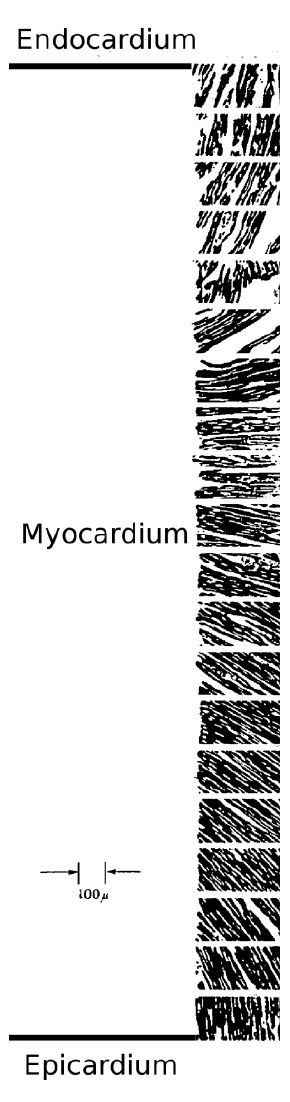
Figure 1. The aligned structure of cardiomyocytes in the myocardium [8]. The alignment is uniform in each layer with a gradual transition of alignment between layers from the endocardium to the epicardium.